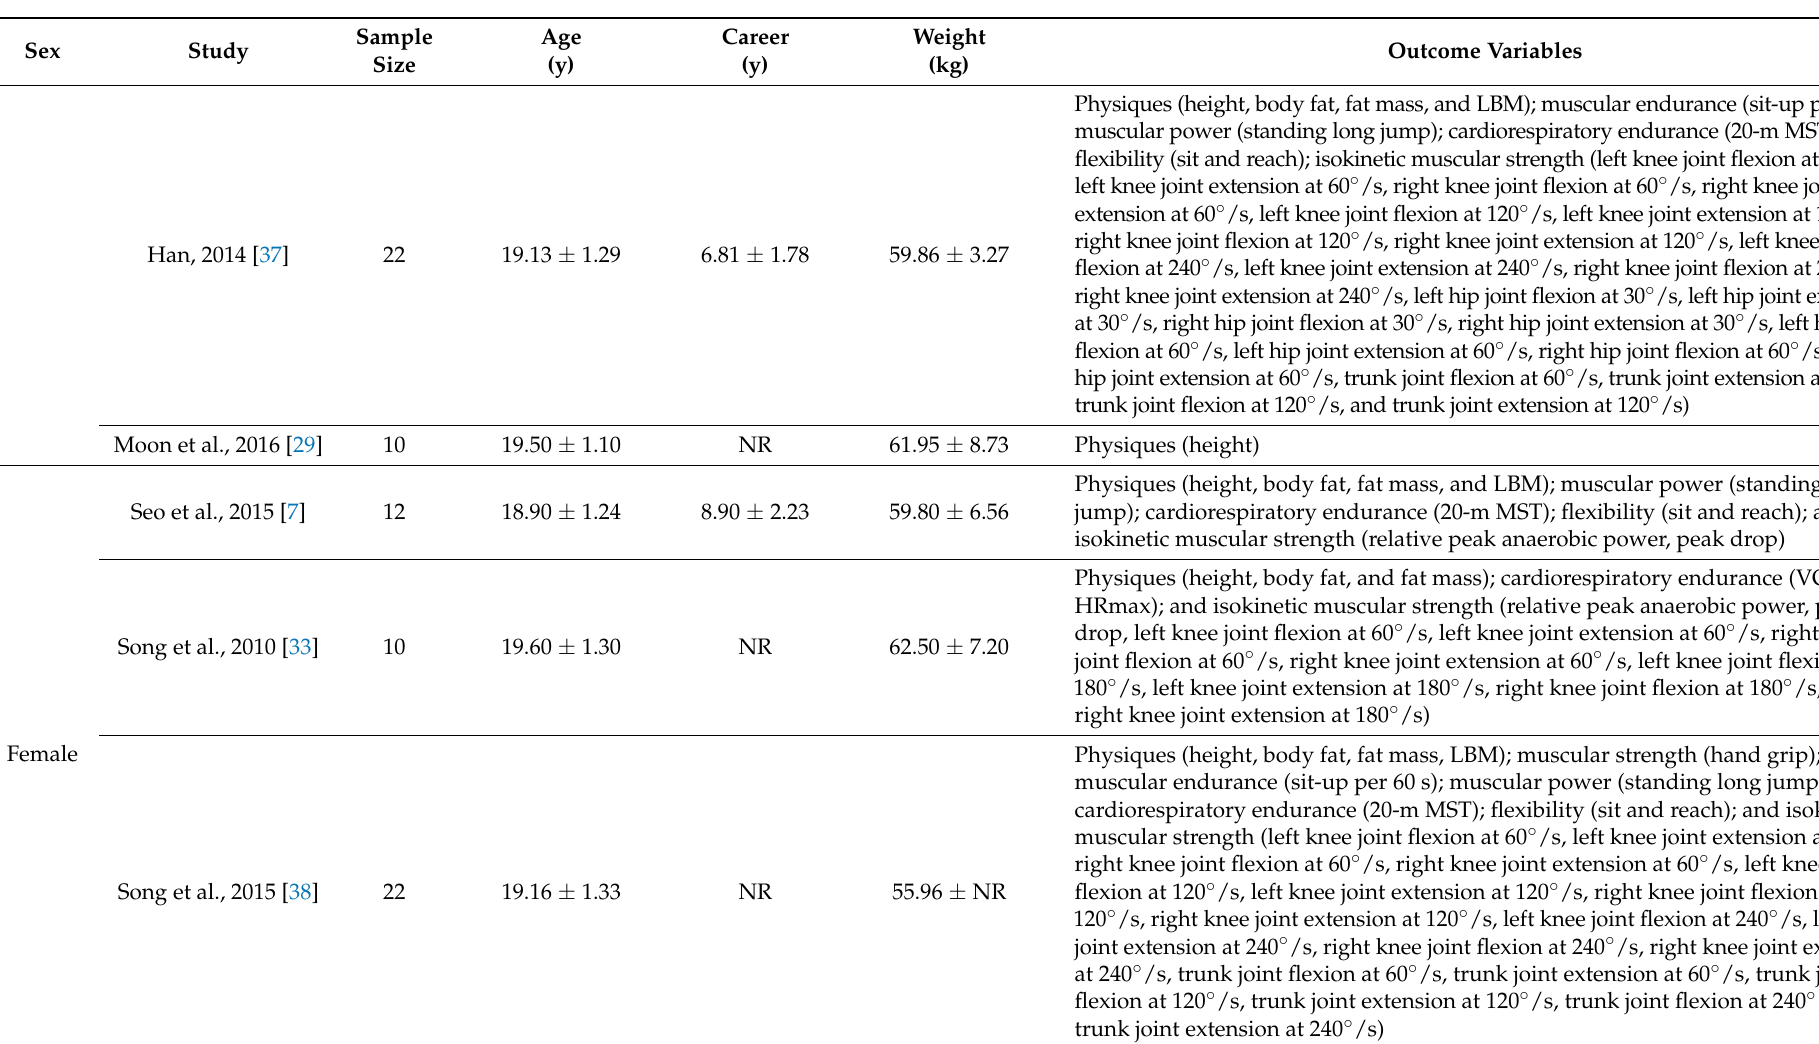
NR, not reported; MST, multistage shuttle-run test; BMI, body mass index; LBM, lean body mass; VO 2 max, maximal oxygen consumption per minute; and HRmax, maximal heart rate per